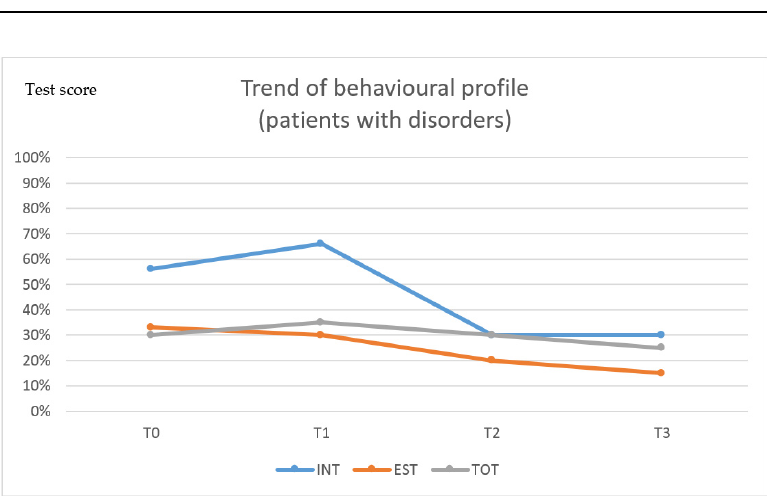
Figure 3. Trend of